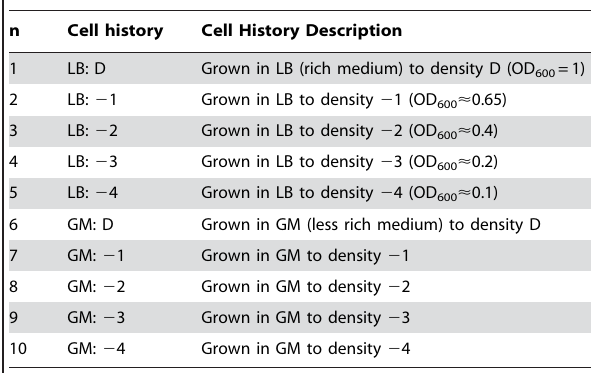
Table 1. Cell history table.